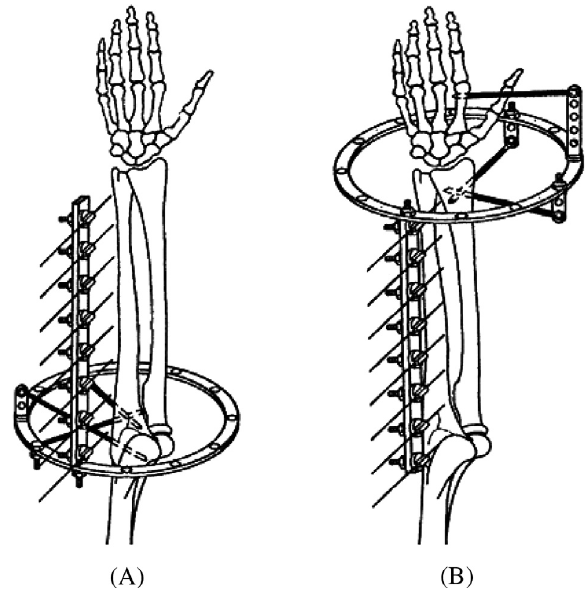
Figure 2. (A) Schematic illustration of the device used to study soft tissue displacement in rotation relative to the ulnar bone. (B) Schematic illustration of the device used to study soft tissue displacement in rotation relative to the radial